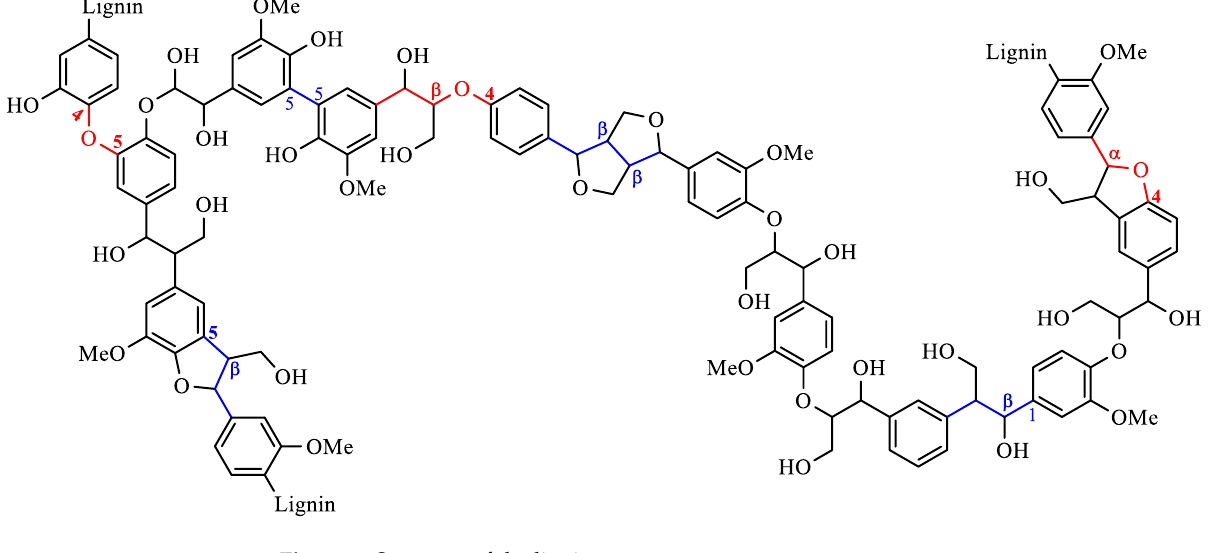
Figure 1. Structure of the lignin.